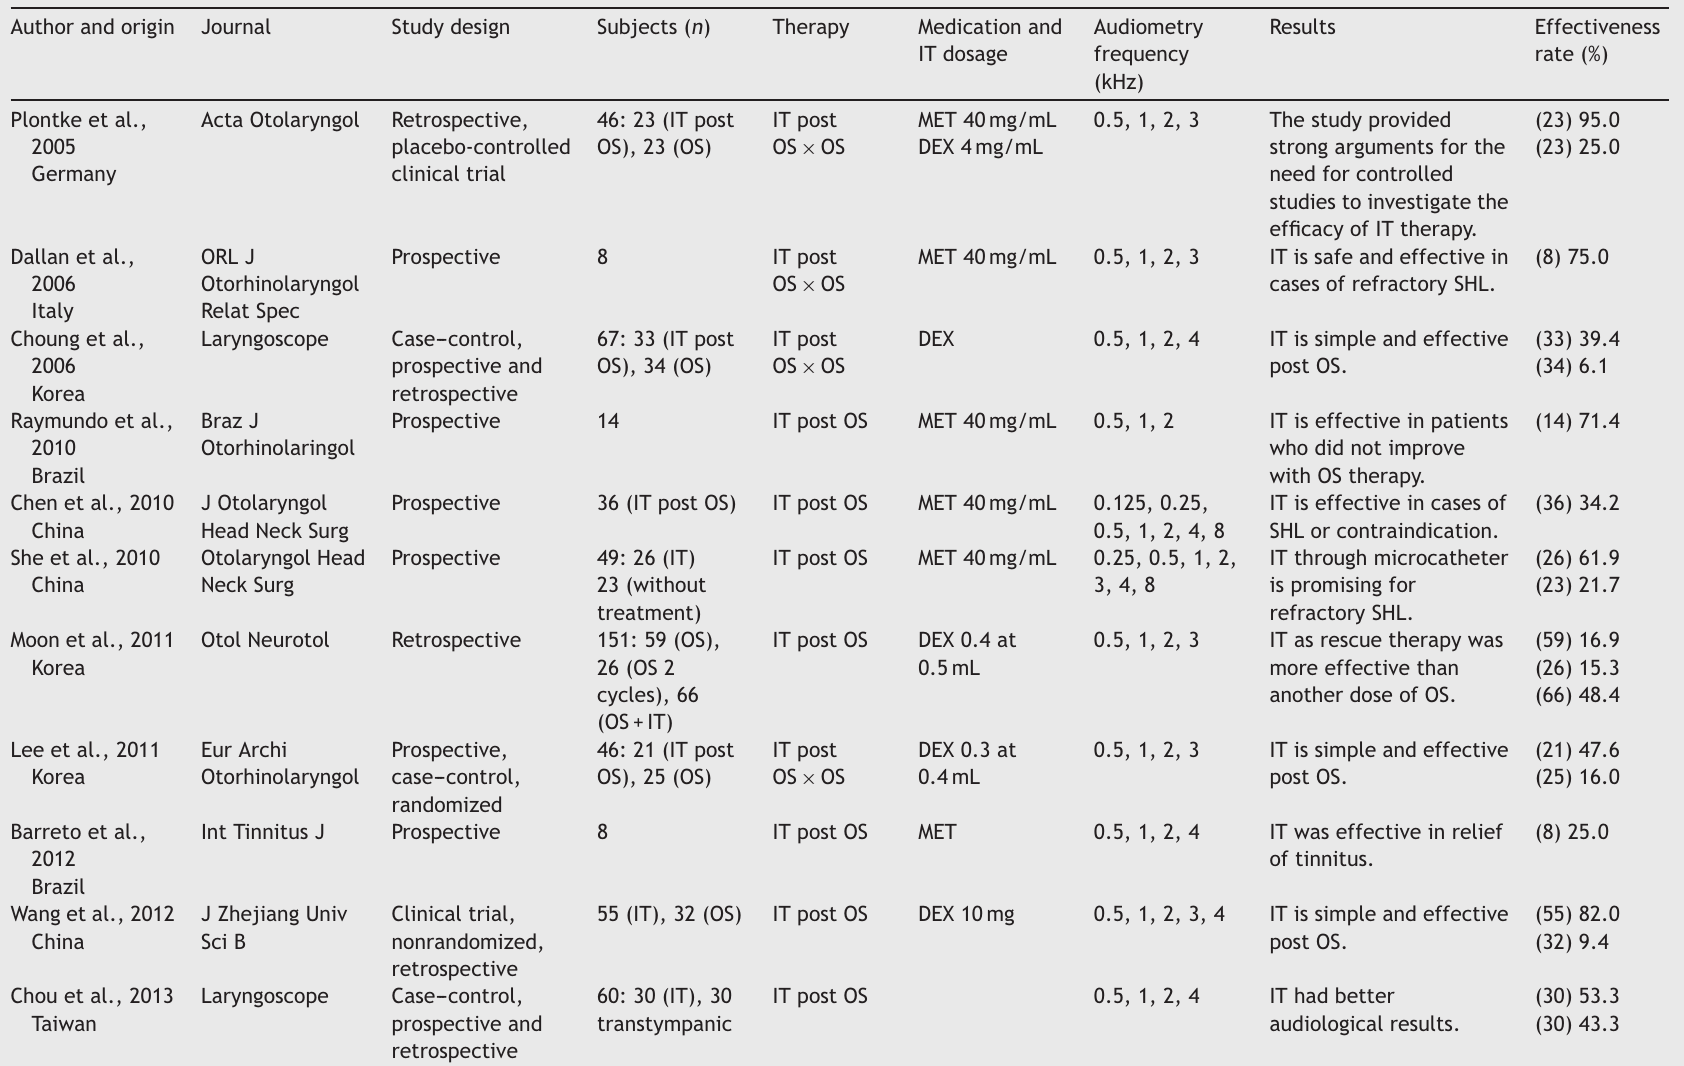
Studies emphasizing salvage therapy failure of oral